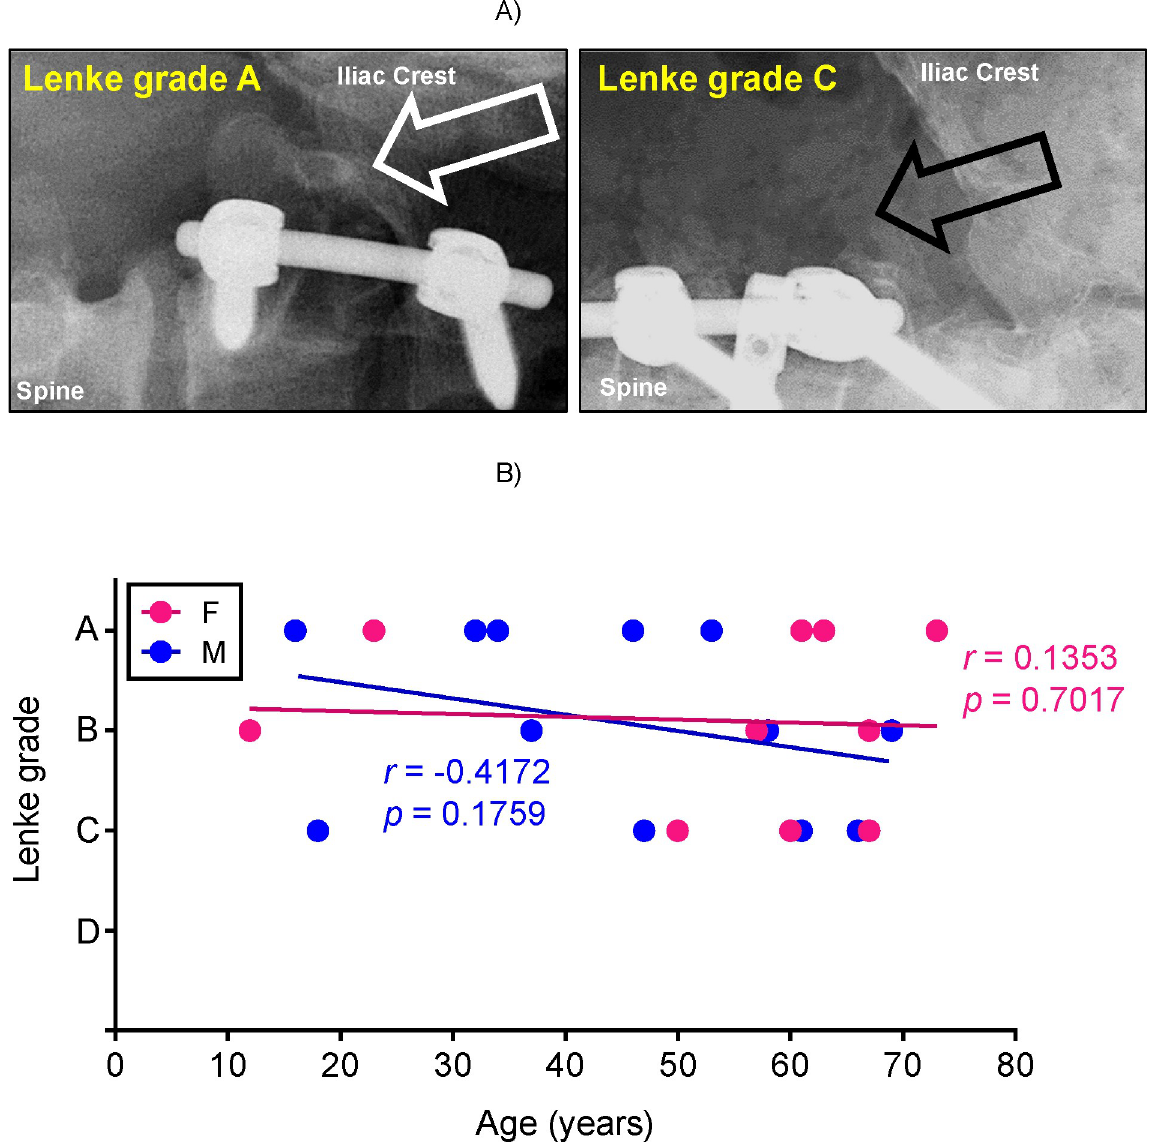
Fig 1. Radiographic Lenke grade does not correlate with patient age. A) At 12 months post-surgery, patients’ radiograms were blindly assessed for osseointegration using Lenke score from A (most fused) to D (no fusion). Representative X-ray images are shown. Arrows indicate the site of fusion; B) Lenke scores were correlated to age of the patient grouped by sex using the Spearman test. There was no correlation between Lenke grade and